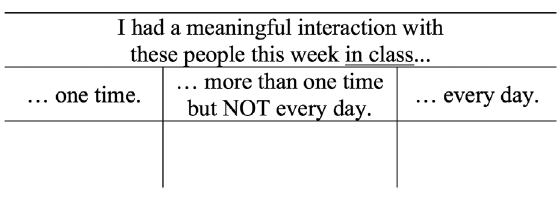
FIG. 4. In each of the networks, X has higher centrality than Y according to (a) indegree, (b) outdegree, (c) eigenvector, (d) closeness, and (e)